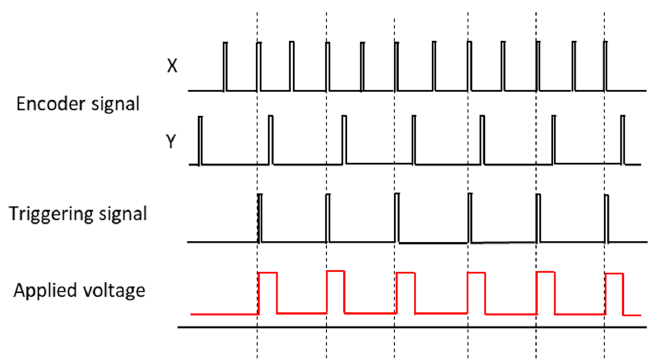
Figure 6. Pulse voltage generation based on two encoder signals.